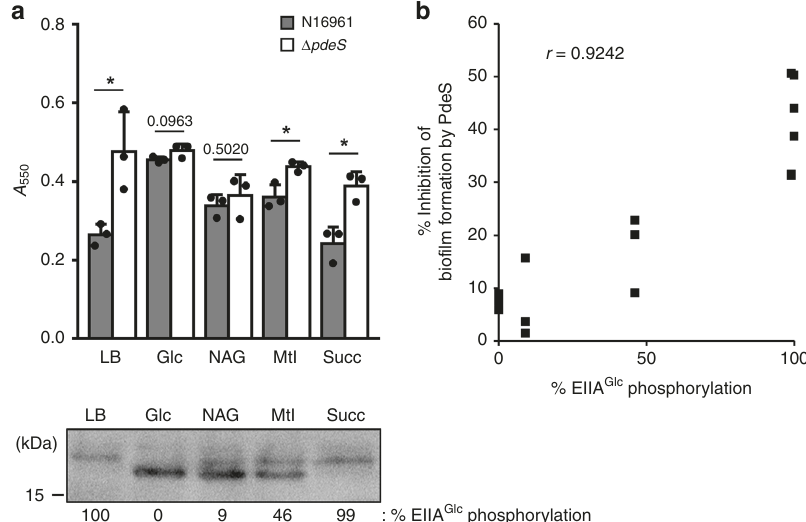
Fig. 4 PdeS regulates bio fi lm formation depending on carbon sources. a The level of bio fi lm formation was compared between wild-type N16961 and a Δ pdeS strain in the presence of various carbon sources in buffered LB medium as in Fig. 3. At the same time, the phosphorylation state of EIIA Glc was determined by western blot using anti-EIIA Glc mouse serum after SDS – PAGE. Statistical signi fi cance was assessed using Student ’ s t -test (* p- value < 0.05, p- values> 0.05 were presented). Glc, glucose; NAG, N-acetylglucosamine; Mtl, mannitol; Succ, Succinate. b The inhibitory effect of PdeS on the bio fi lm formation was plotted as a function of EIIA Glc phosphorylation. Based on the data in panel a , the degree of bio fi lm formation of wild-type cells was divided by that of the Δ pdeS mutant cells. The percentage of bio fi lm formation inhibition by PdeS was then calculated by subtracting the resultant value from 1 and multiplying by 100, then plotted as a function of the percentage of phosphorylated EIIA Glc over total EIIA Glc . The correlation between the sugar-mediated phosphorylation state of EIIA Glc and bio fi lm formation was assessed using Pearson ’ s correlation coef fi cient ( r = 0.9242, p < 0.005). Shown are the means and SD ( n = 3, independent